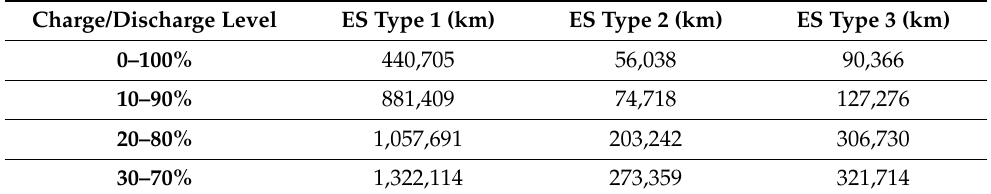
Table 8. Total achievable range for different types of energy storage -WLTC test at 20 ◦ C ambient